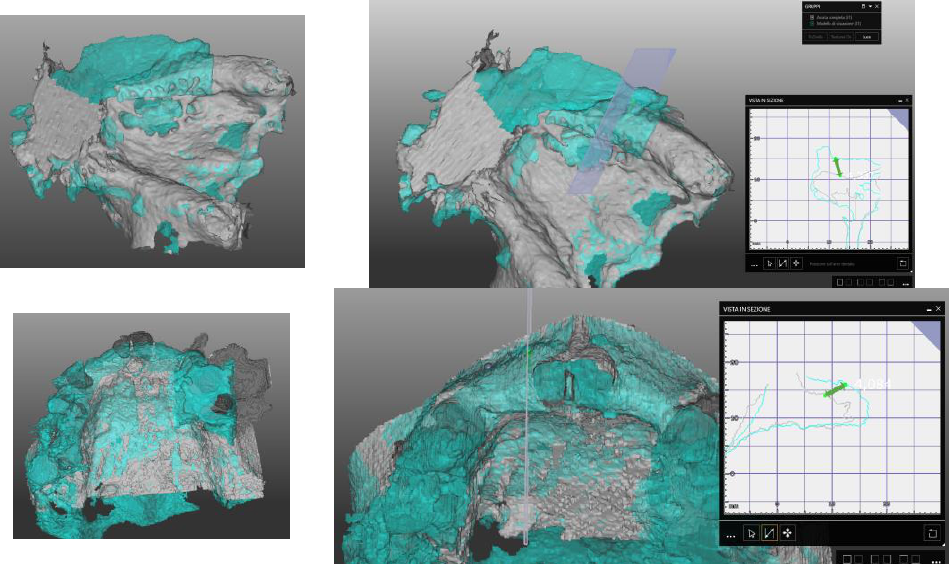
Figure 7. Segmentation of Dicom file and (T0 – T1) CBCT superimposition to evaluate horizontal, vertical and bone volume gains for upper jaw case.